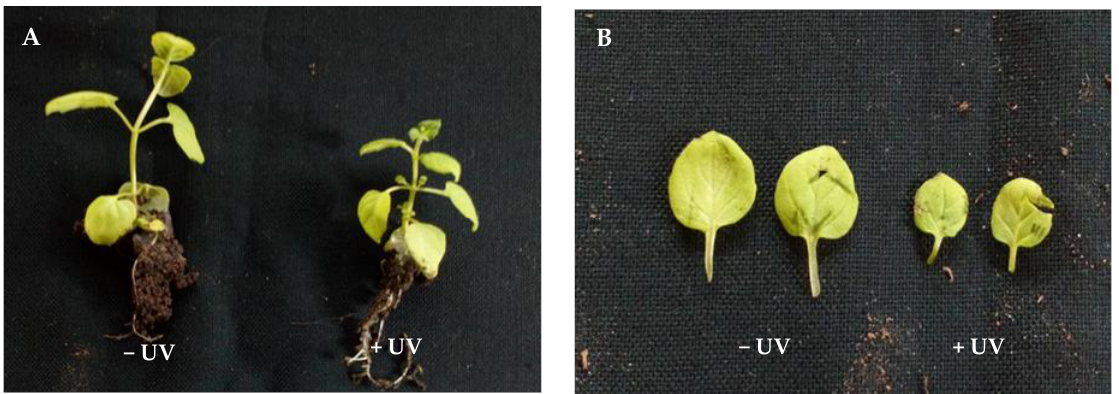
Figure 2. The effect of UV on mint morphology. Changes in plant size and branching ( A ) and leaf area and petiole length ( B ) between non-UV-exposed plants and UV-exposed plants.